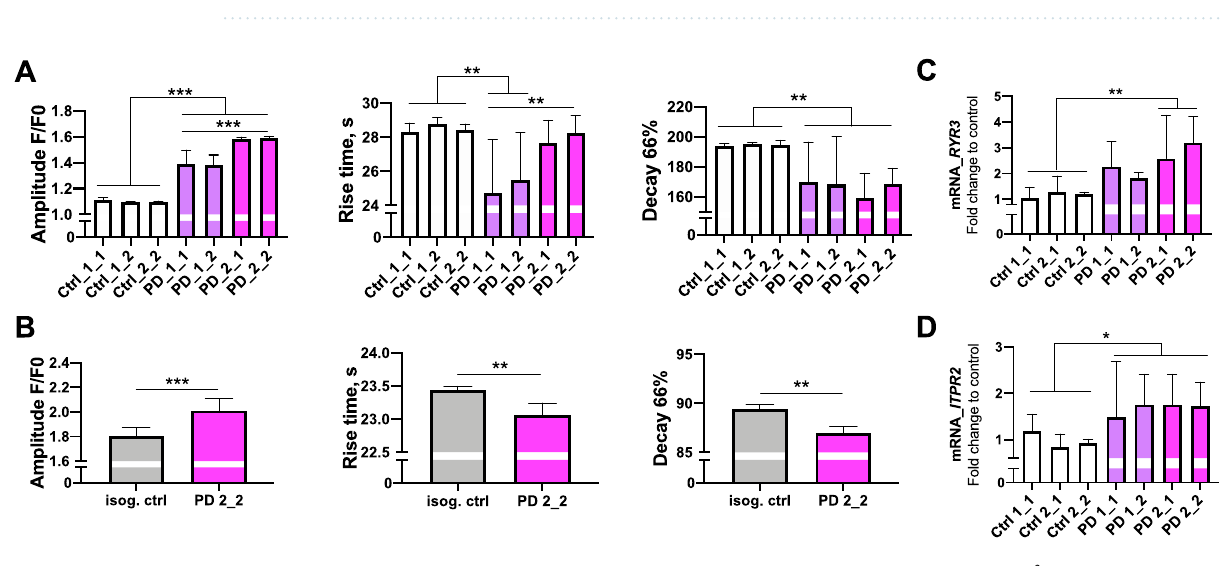
Figure 4. Disturbed calcium signaling in endoplasmic reticulum of PD astrocytes. The [Ca 2+ ] i signals in healthy, PD and isogenic control-derived astrocytes. ( A ) The amplitude F/F 0 , rise time and decay time in seconds (66%) of Ca-responses caused by ryanodine receptors activation (stimulation with cresol) in healthy and PD astrocytes. ( B ) Repeated experiment with isogenic control and PD astrocytes showing that the G2019S mutation in LRRK2 is responsible for the calcium disturbances in PD astrocytes, n = 800–1,200 cells. Bars represents mean ± SEM. Relative gene expression levels of ER calcium-channels ( C ) RYR3 and ( D ) ITPR2 (inositol 1,4,5-triphosphate receptor type 2) in astrocytes shown as fold change from healthy control. Results are presented as mean ± SD from three independent experiments, *p < 0.05, **p < 0.01, ***p <